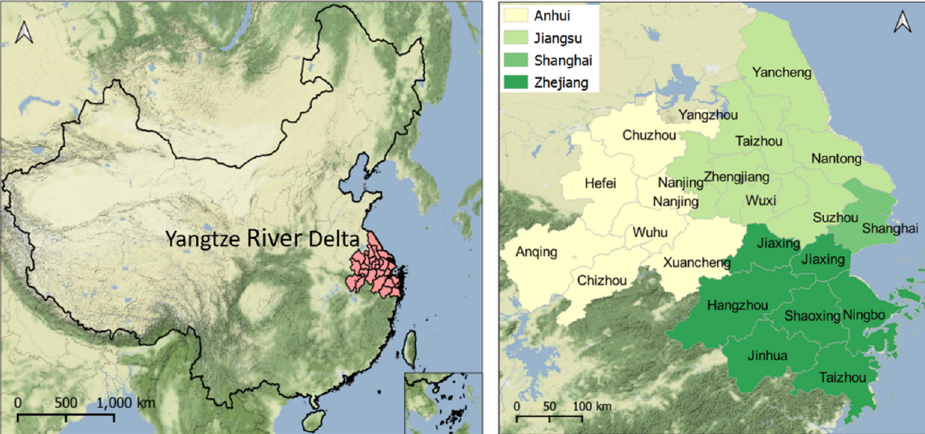
Figure 1. Location of the YRD in China and demarcation of the study area.